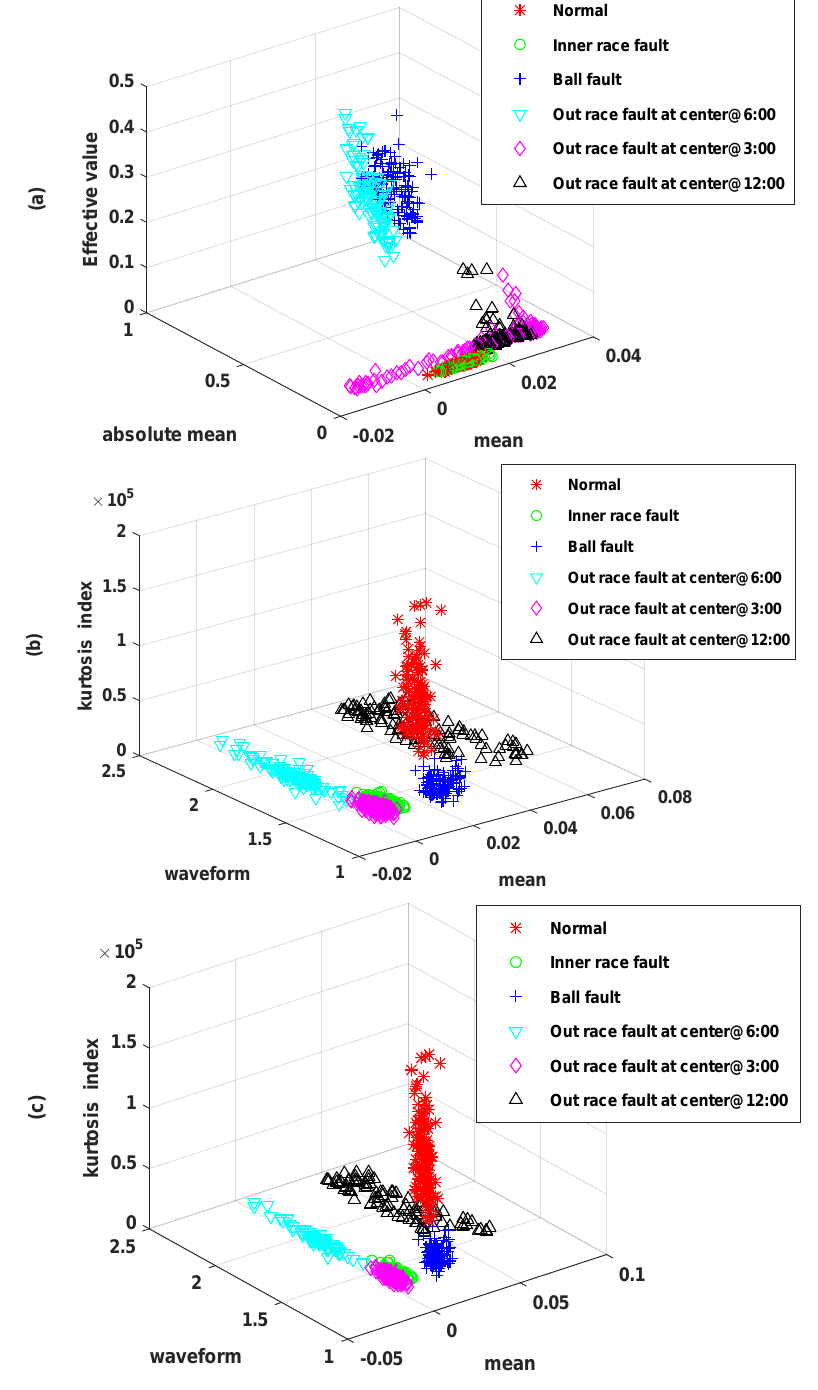
Figure 9. Bearing data description. ( a ) the original signal time domain feature extraction fault three-dimensional; ( b ) J48 select the characteristics of the three-dimensional fault data diagram; ( c ) the three-dimensional fault data diagram after J48 and SSVM